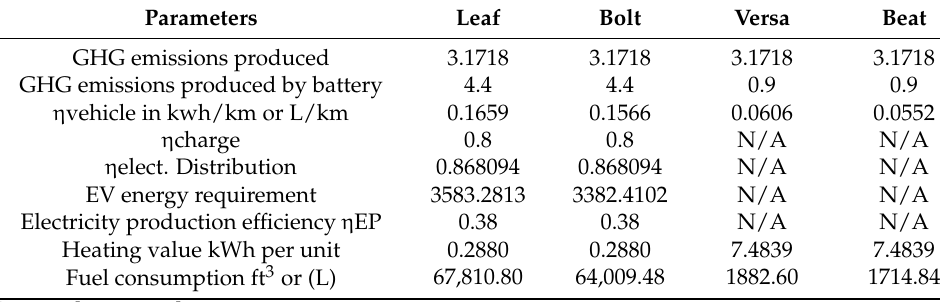
Table A3. Parameters used for environmental impact calculation.